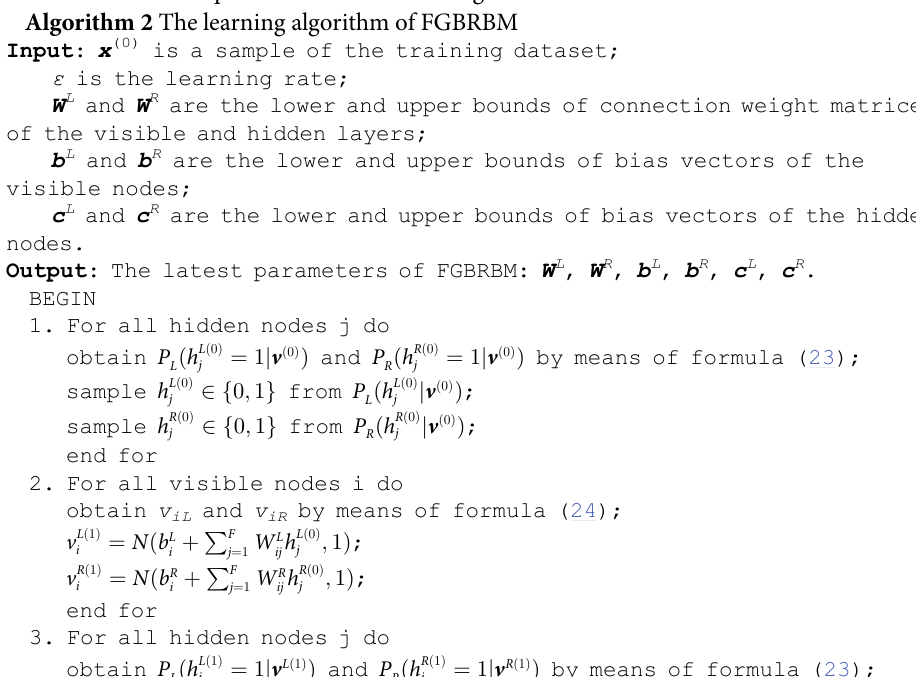
Algorithm 2 The learning algorithm of